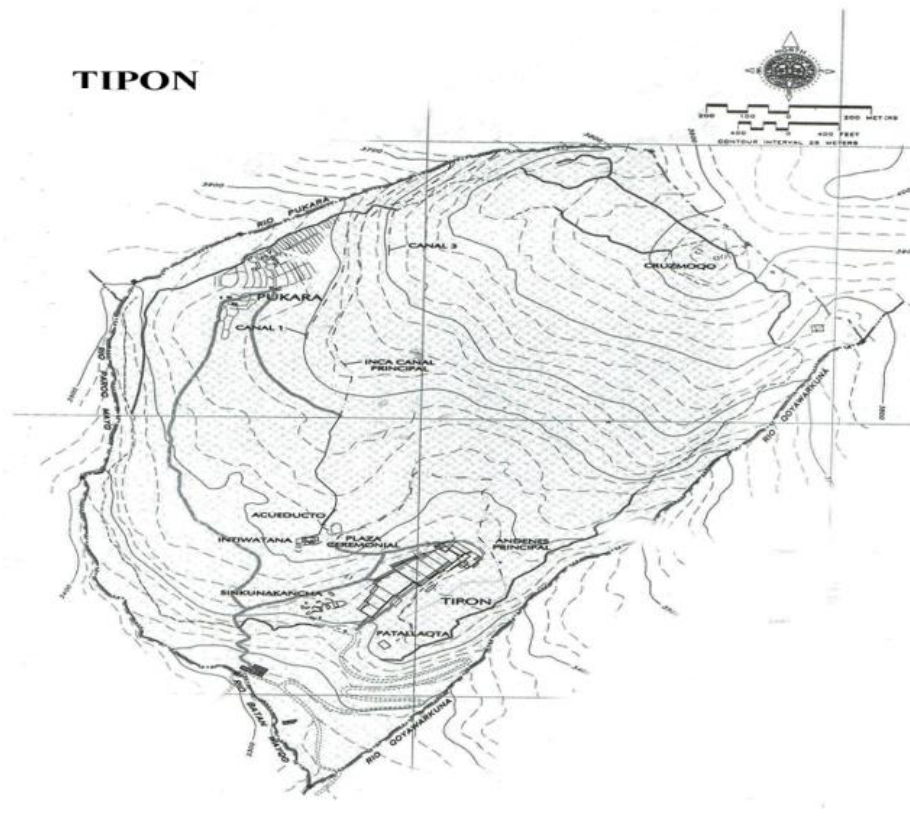
Figure 64. Site feature map of Tipon from Wright et al. 2006 [46].